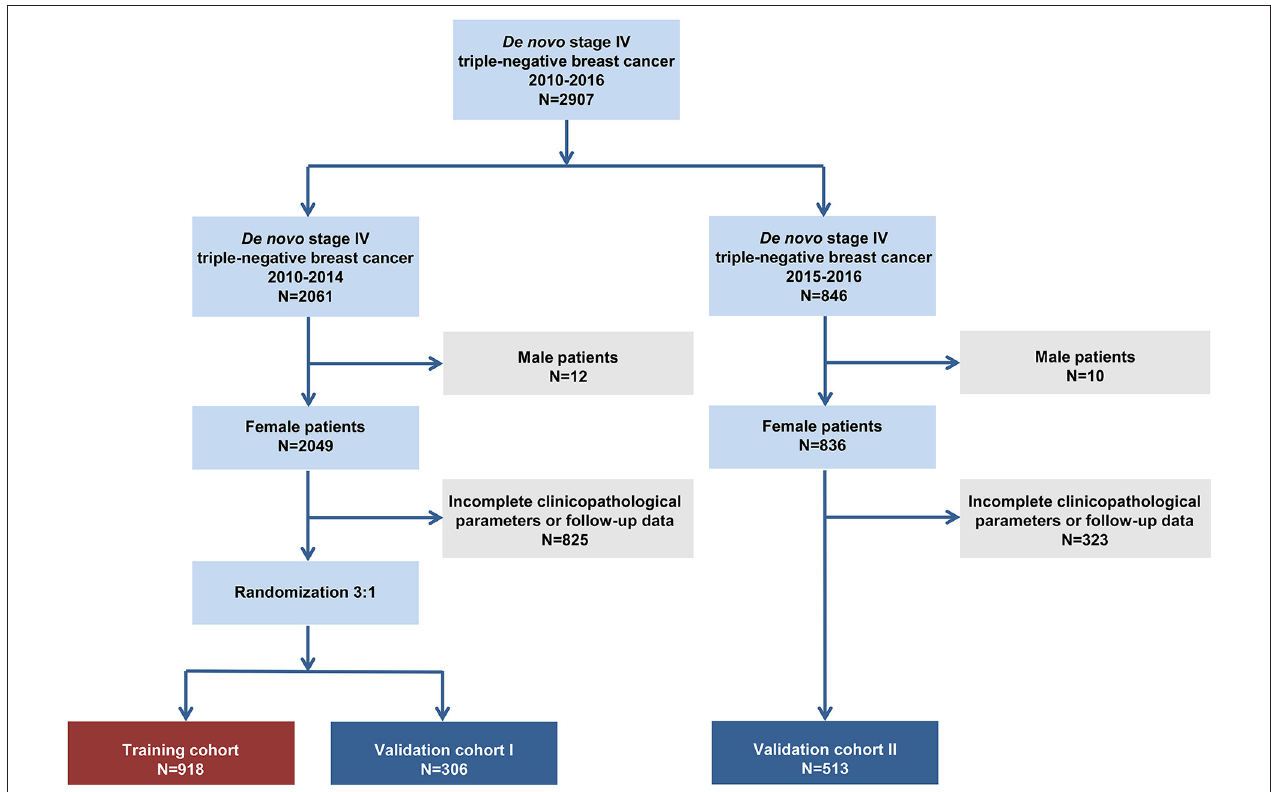
FIGURE 1 | Patient selection